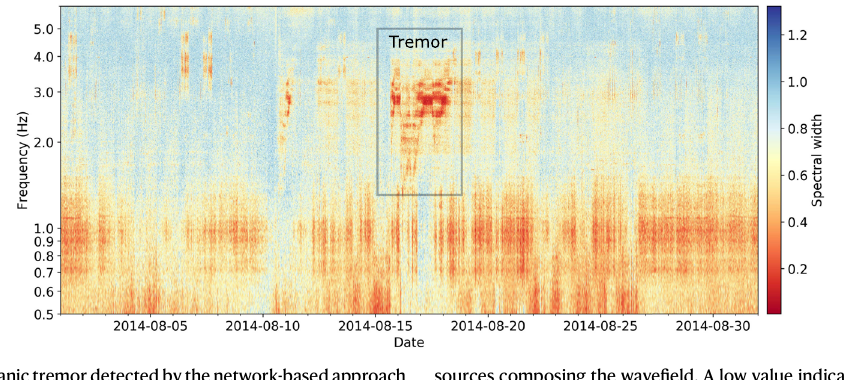
sources composing the wave fi eld. A low value indicates a coherent signal in the network (stations used: KAD, KID, KMD, MKO, MTB, NGR,